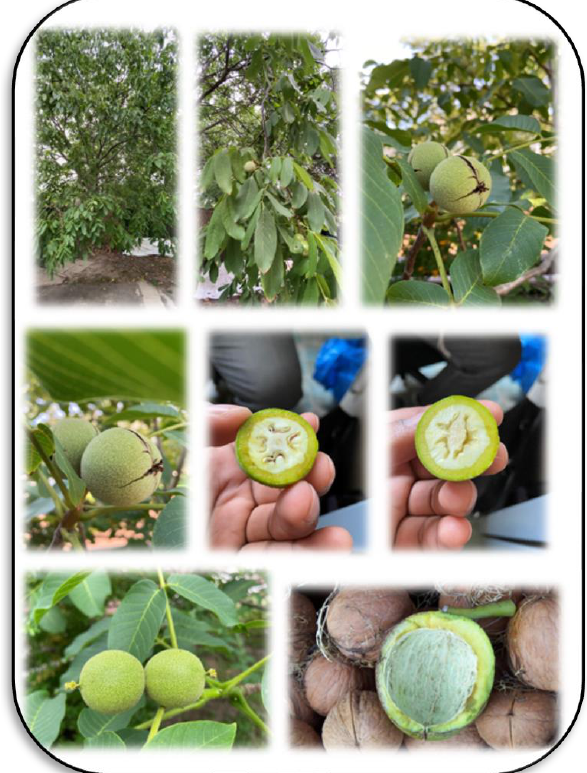
Figure 1. An overview of the walnut plant; the tree of walnut, and their green fruits in the three upper photos; in the middle some sections in the green walnut fruits, and the lower right photo represents the green and manure walnut fruits. Photos by Ayaz .